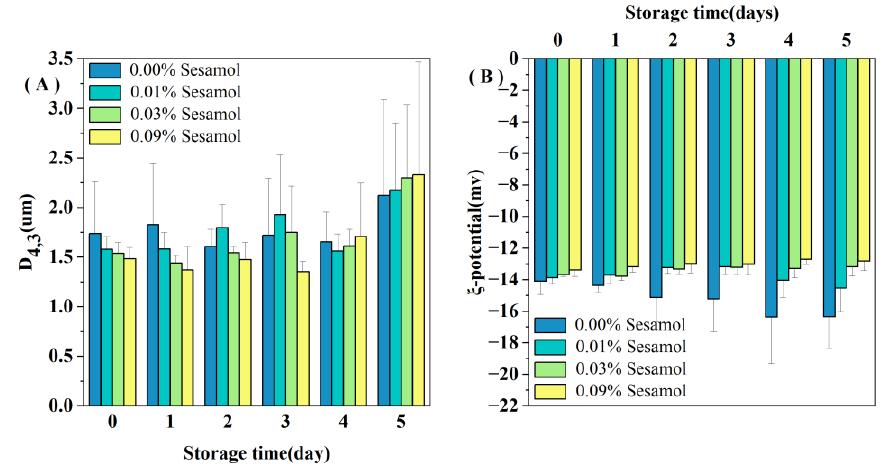
Figure 1. Changes in the mean droplet size D 4,3 ( A ) and ζ -potential ( B ) of emulsions containing different levels of sesamol during storage (30mL of emulsion in a 50mL glass bottle with screw cap stored at room temperature and protected from light).